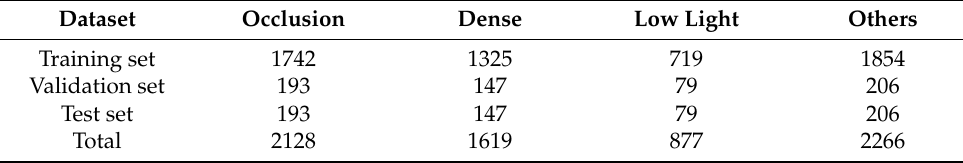
Figure 1. The image acquisition apparatus. Table 1. The dataset of